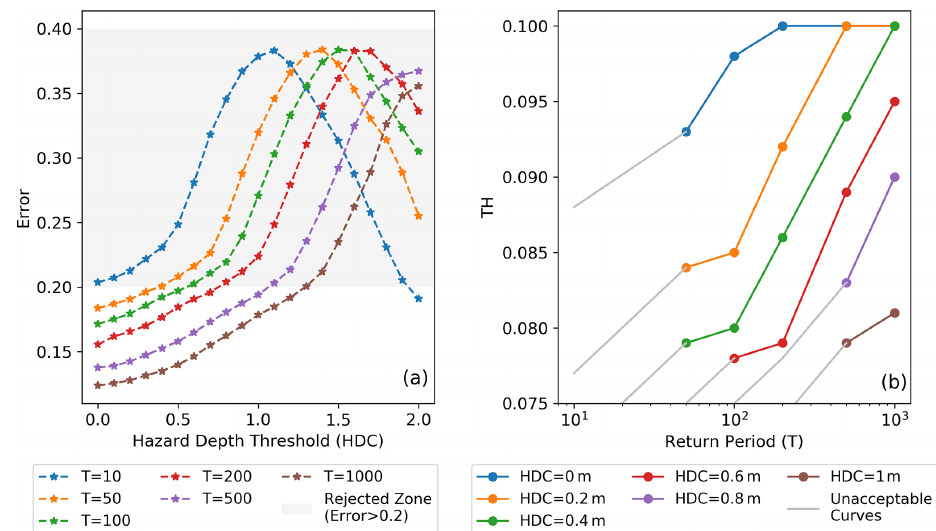
Figure 7. (a) The errors in flood hazard maps generated by the calibrated hydrogeomorphic method for different return period flood events and hazard depth cutoff (HDC) values. (b) The hydrogeomorphic threshold operative curves provided for different HDC values. These operative curves are the major tool for fast flood hazard mapping as, depending on the return period of a future flood event and the HDC value chosen by the decision maker, the operative curves estimate the hydrogeomorphic threshold. Knowing this threshold, the flood hazard map will be generated in a few